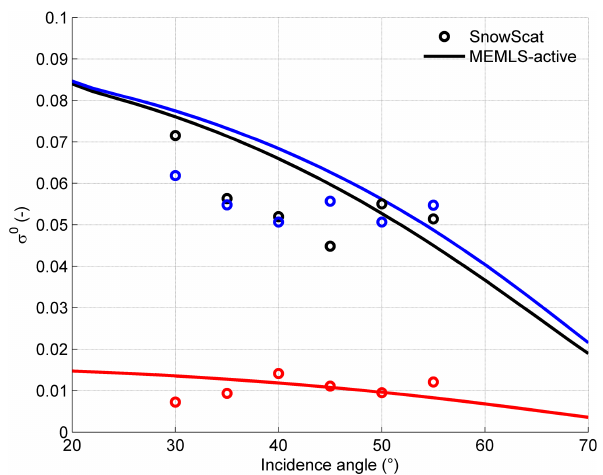
Figure 10. σ 0 at incidence angle 50 ◦ measured by SnowScat (cir- cles) and modeled by MEMLS3&a with CT input (lines) for differ- ent specular snow–ground reflectivities s s0 . Higher s s0 values lead to lower σ 0 values and vice versa. Colors represent polarization, with vv – black, hh – blue and hv – red. Best fit parameters accord- ing to Fig. 7.